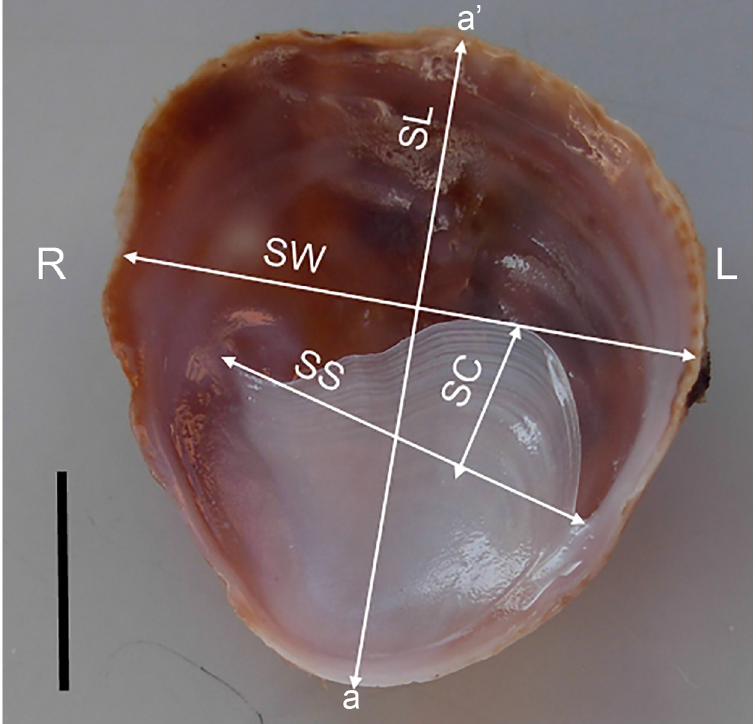
Fig 1. Apertural view of a Crepipatella dilatata morphotype IV shell showing the four linear shell dimensions measured for the PCA. Abbreviations: a-a’, antero-posterior axis; L, left side of the shell; R, right side of the shell; SC, height of the septum curvature; SL, shell length; SS, width of the shell septum; SW, shell width. Scale bar: 1